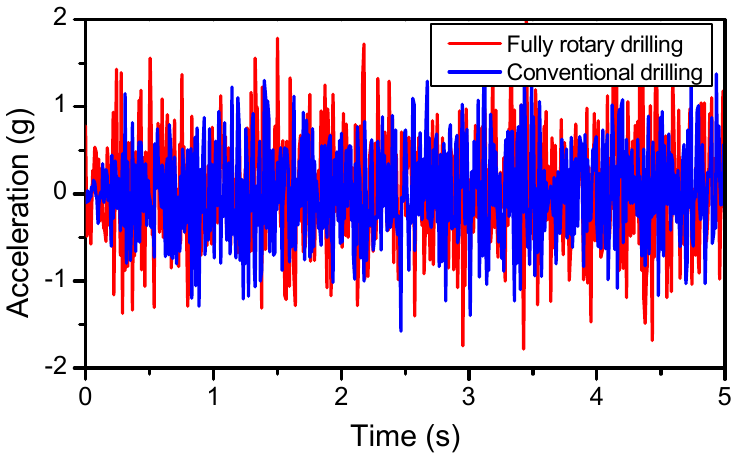
Figure 5. Axial acceleration versus time on the BHA for both fully rotary and conventional drilling.